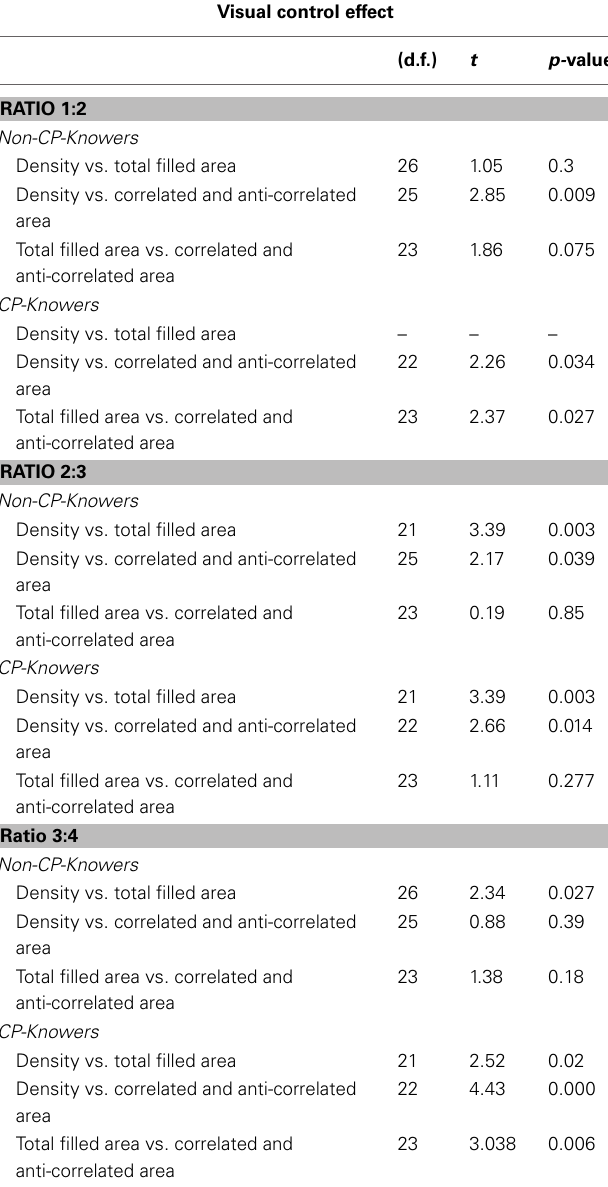
Table 2 | Statistics for the visual control effect divided by ratio and cardinality knowledge.